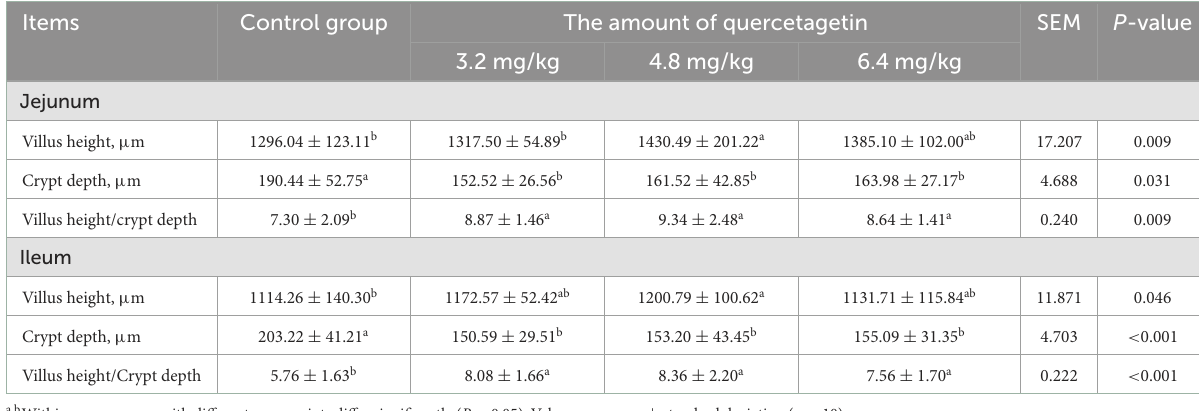
TABLE 4 Effect of quercetagetin on intestinal morphology of broilers.